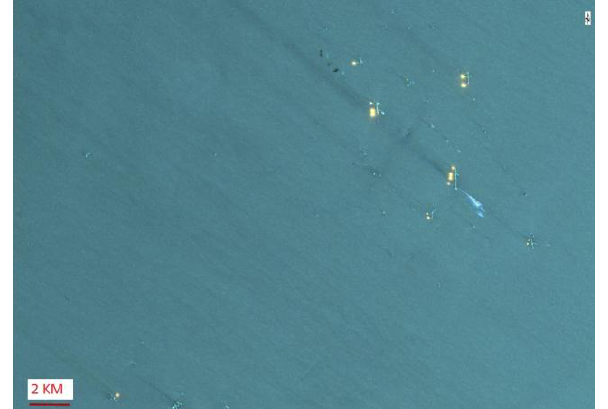
Figure 5d; same area, SWIR channels. LANDSAT-8, 12 th April 2015. Only the recurrent seep is visible. Figure 5b show a false colour images with red-green-blue Figure 5a. Natural colour image of giant oil field with natural channels being the SWIR2, SWIR1 and NIR channels from the seepage in A and non recurrent oil spill in B. LANDSAT-8, 24 th LANDSAT image. As expected, the northern limit of the spill March 2014. (area B) which is thicker appears brighter than the surrounding oil-free water. On the contrary, most of the spill is darker than surrounding waters, indicating sub-millimetric thickness. Figure 5c, is the thermal infra-red channel TIR1 intensity. The oil spill is barely visible. Only the thickest part appears more cooler/darker than surrounding waters: resolution of the TIR channel is 100m compared to 30m for the visible and NIR- SWIR